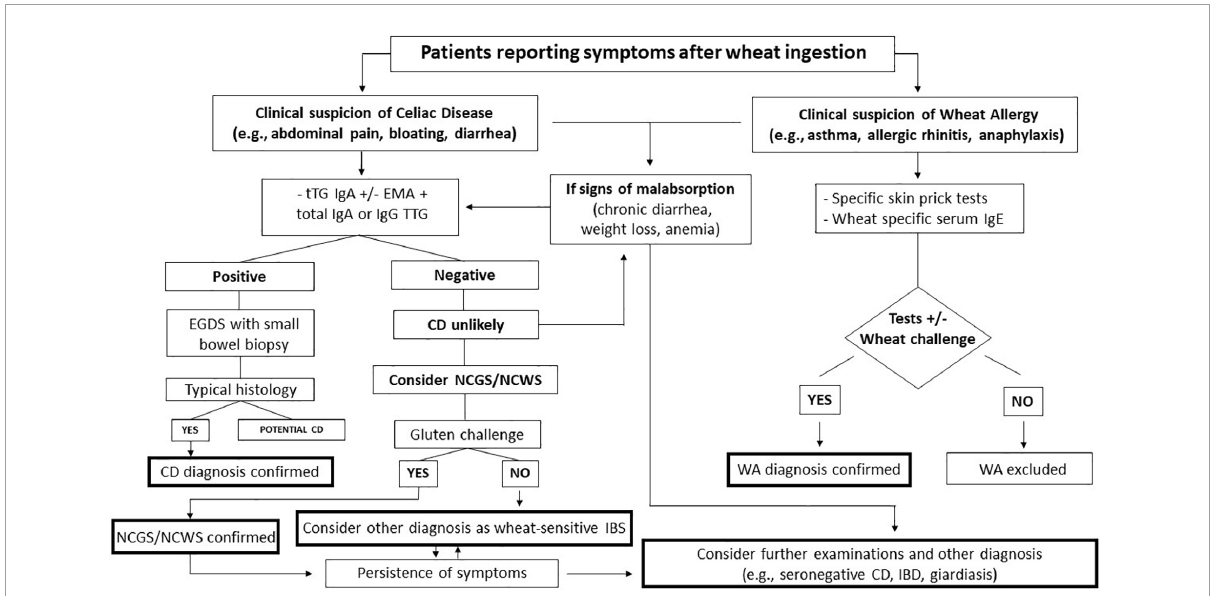
FIGURE1 Flow chart of the management of patients reporting symptoms after wheat ingestion. CD, celiac disease; EGDS, esophagogastroduodenoscopy; EMA, endomysial antibody; NCGS/NCWS, non-celiac gluten-wheat sensitivity; tTG; transglutaminase; WA, wheat allergy; IBS, irritable bowel